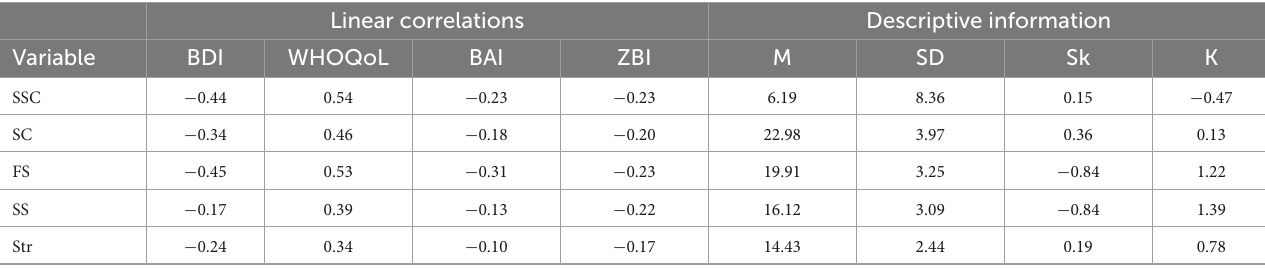
TABLE 4 Standardized linear regression slopes to evaluate the validity of factor score measures in primary caregivers. Linear